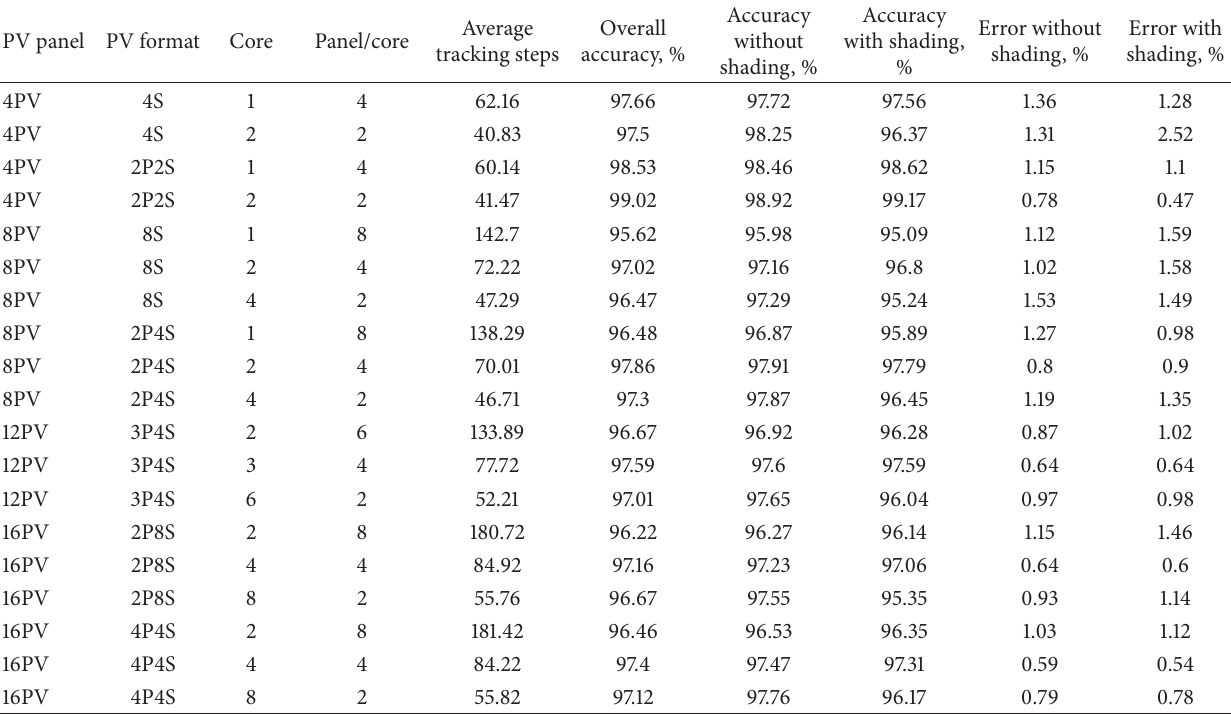
Table 7: Performance of the proposed multicore PSO MPPT algorithm using